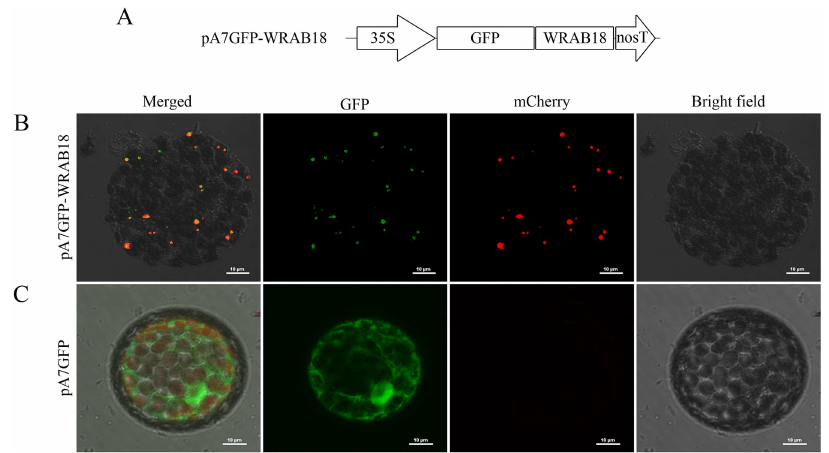
Fig 6. Subcellular localization of WRAB18 in protoplasts of Nicotiana benthamiana leaves. (A) Schematicrepresentation of recombinant vector pA7GFP::WRAB18. (B) Plastid localization of GFP:: WRAB18 in protoplasts of N . benthamiana leaves. Plastid marker protein fluorescence was dispersedin the mCherry channel. GFP::WRAB18 fusion protein fluorescence was merged with the fluorescence emitted by the plastidmarker protein. (C) Non-specificlocalization of GFP protein in protoplasts of N . benthamiana leaves. Images were taken from the eGFP, mCherry channelbright-field, and merged images channels. The bar indicates10 μ m.